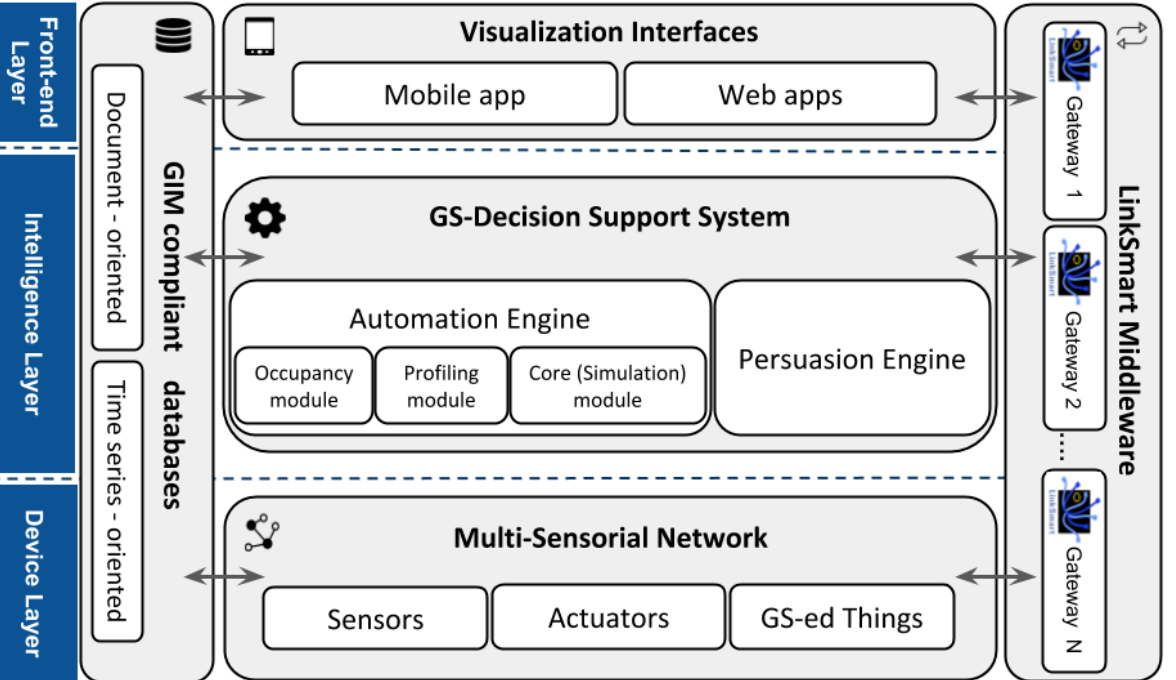
Figure 3. GreenSoul Reference Architecture